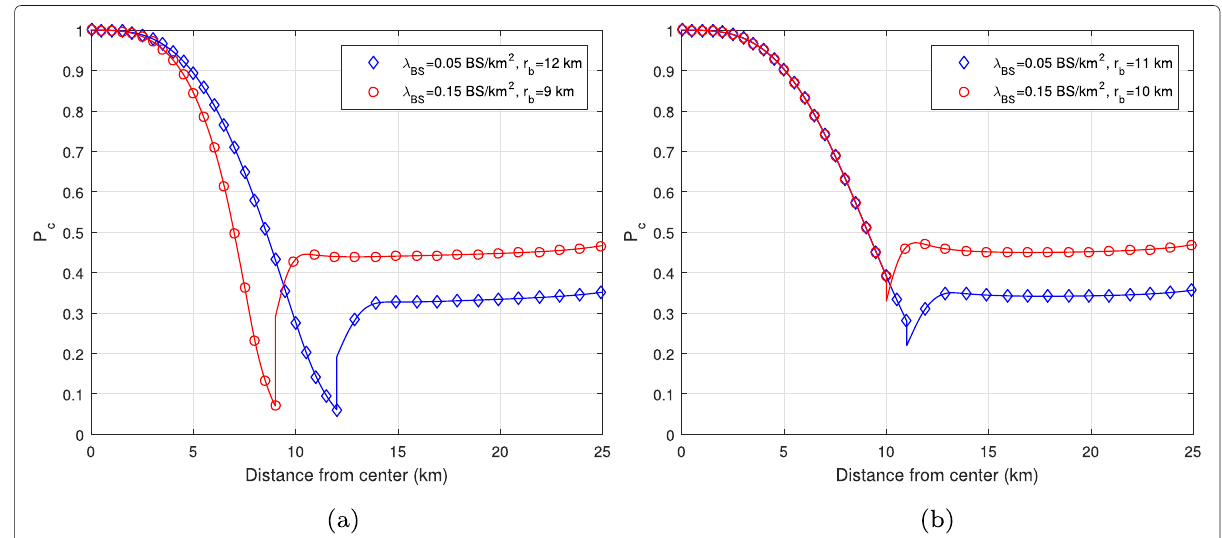
Fig. 9 Probability of coverage as a function of distance from center for two values of λ BS and their corresponding values of r b for − 105dBm noise power and T = 0 dB. a Shared spectrum scenario b Dedicated spectra scenario